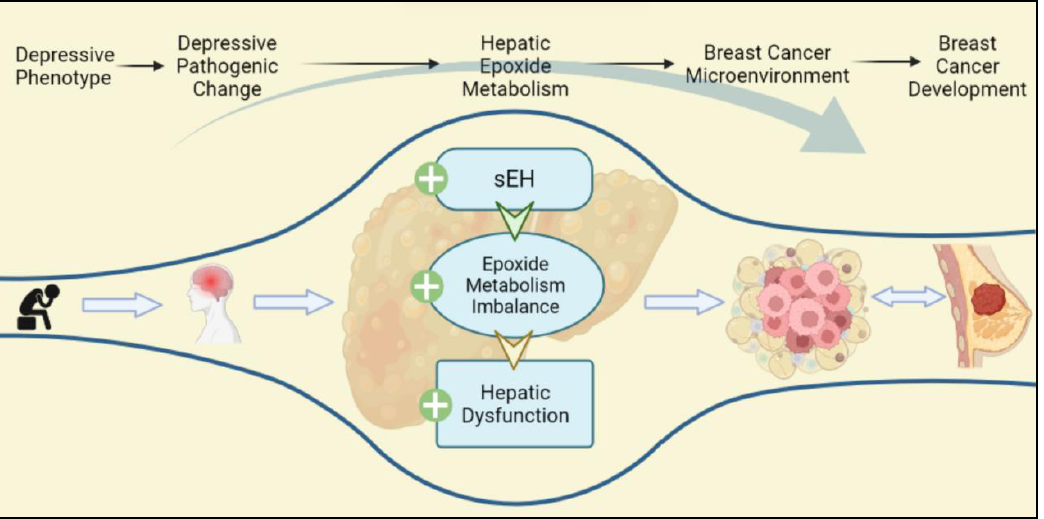
Figure 5. Depressive phenotypes are the prestage of depression, which can also lead to the depressive pathogenic change progressing. Depressive phenotypes specifically upregulate hepatic sEH, which contribute to hepatic dysfunction, epoxide metabolism imbalance, and lipid metabolism disorder. The hepatic pathogenic change promotes the TEM of BC, thereby strengthening the development of BC.